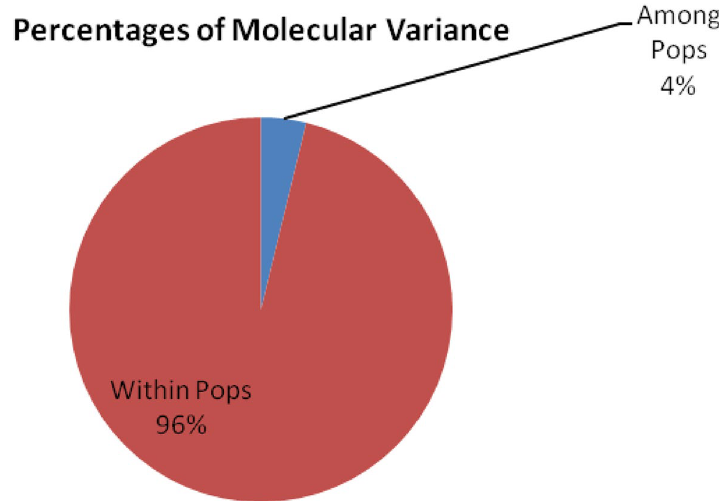
Fig. 4 AMOVA showing genetic variance within and among